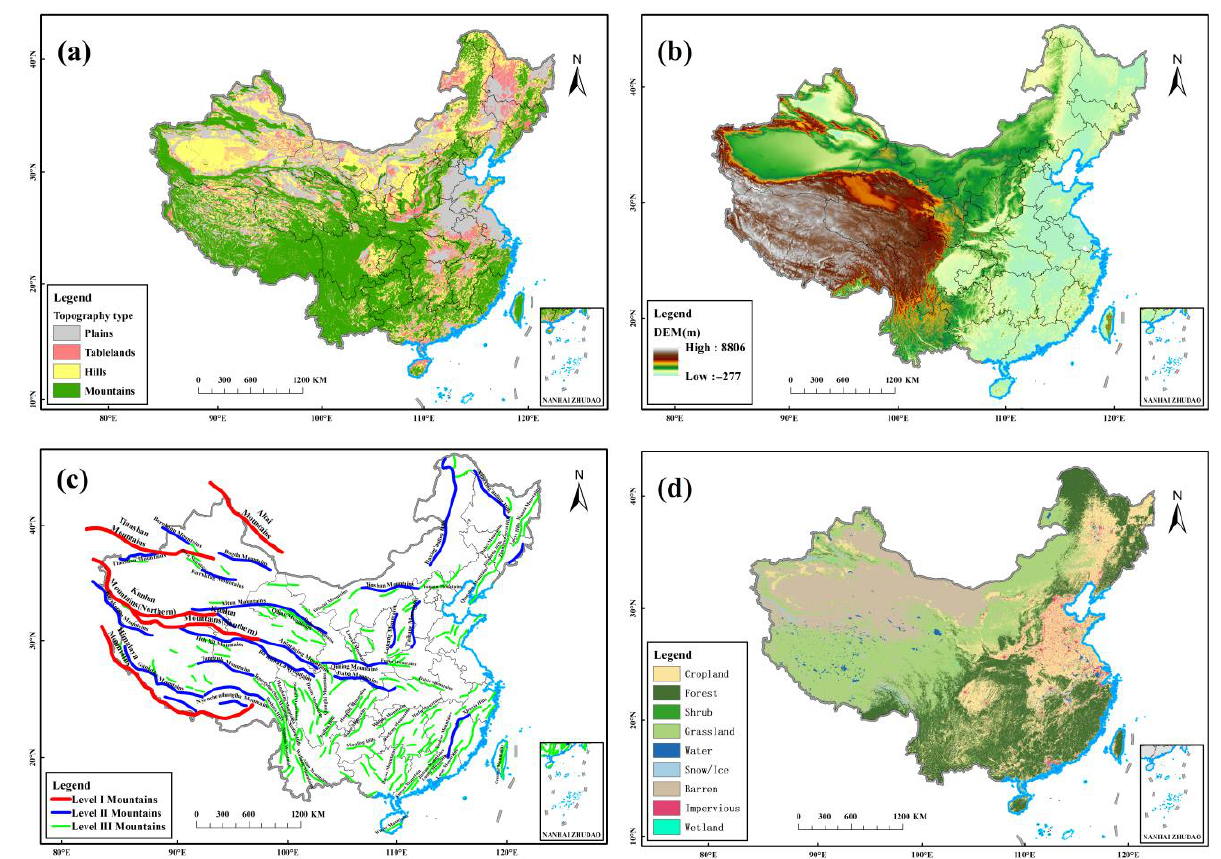
Figure 1. The spatial distribution of the Geomorphologic Atlas of the People’s Republic of China (1:1 million, ( a )), digital Elevation Model data ( b ), major mountain ranges ( c ), land cover data ( d ). Table 1. Classification system of the basic geomorphologic types of Chinese territory [60]. NO. Geomorphologic Types